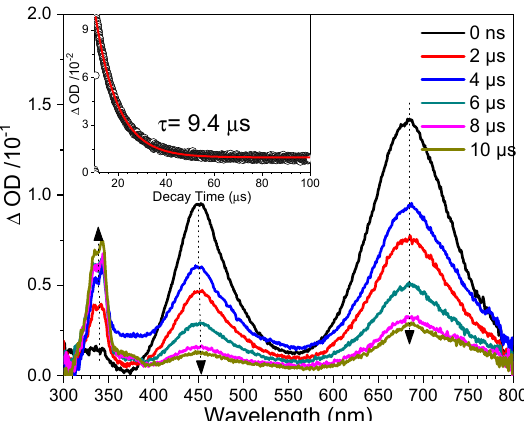
Figure 3. Shown are ns-TA spectra obtained in a 1:1 MeCN:H 2 O solution after 266 nm irradiation of DN. The kinetics at 450 nm appear in the insert.